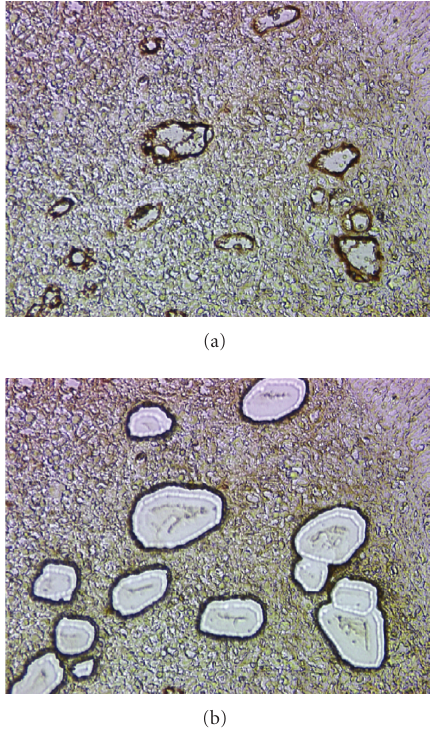
Figure 2: Immune-LCM used for retrieval of Factor VIII-positive endothelial cells from FFPE tissue sections. (a) Factor VIII+ endothelial cells in the head and neck carcinoma. (b) Retrieval of Factor VIII-positive endothelial cells. This step is performed after dissecting blood cells in Factor VIII-positive